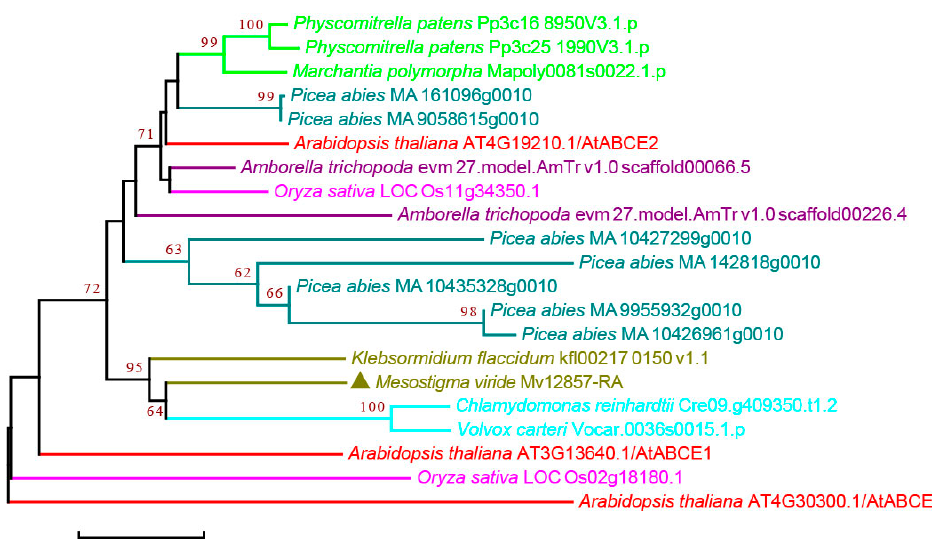
Figure 6. Phylogenetic analysis of ABCE subfamily proteins from 11 evolutionarily representative plant species. A neighbor-joining (NJ) tree was generated using MEGA7 with 1000 bootstrap repli- cates, and bootstrap values >50% are shown on the branches. The M. viride proteins are highlighted by triangles.